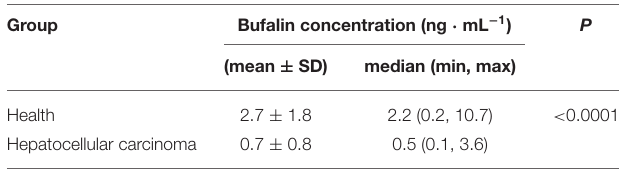
TABLE 2 | The comparison of endogenous bufalin concentration between healthy volunteers and hepatocellular carcinoma patients.